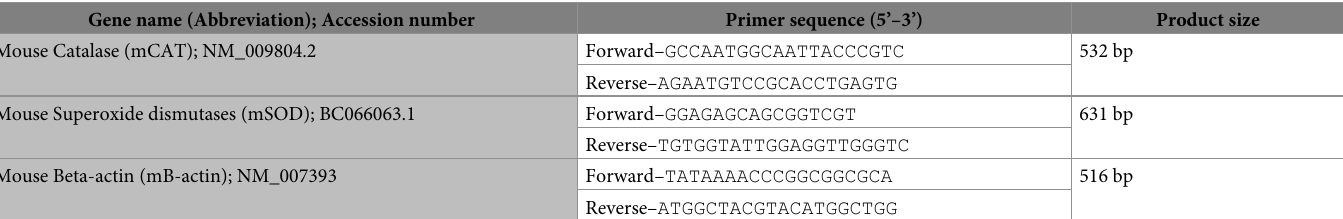
Table 2. Primers and PCR conditions used for the tested